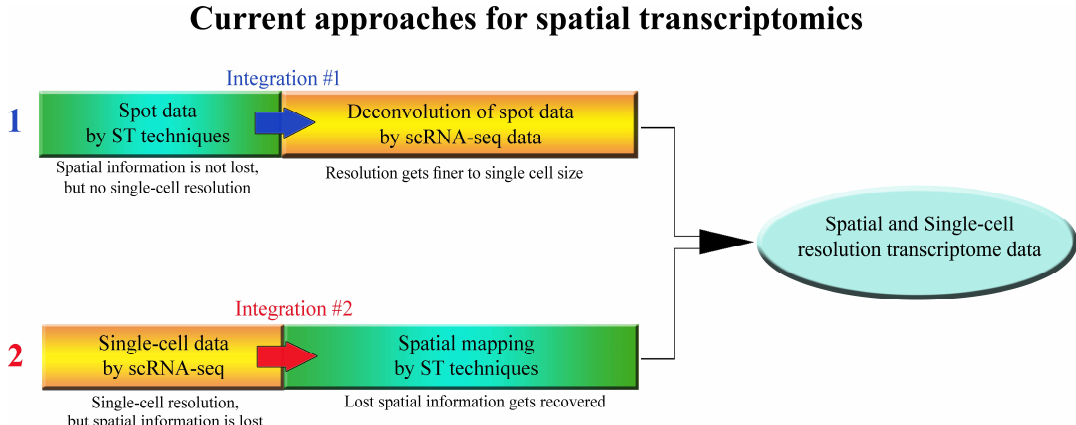
Figure 2. Integrative approaches for current spatial transcriptomics for developmental biology studies. There are mainly two ways to integrate both techniques: (1) spatial transcriptome data is generated at spot resolution, and then the spot data is further deconvolved into single-cell data using scRNA-seq data, and (2) single-cell transcriptome data is generated by scRNA-seq and then lost spatial context is recovered through spatial mapping of scRNA-seq data by ST techniques.